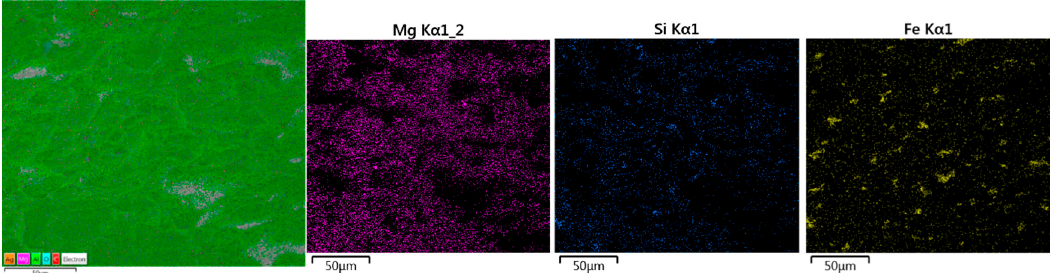
Figure19. EDSanalysisofwroughtfracturesurfaceafterB117testing, showingevidenceofsecond-phase particle concentrations of Mg, Si and